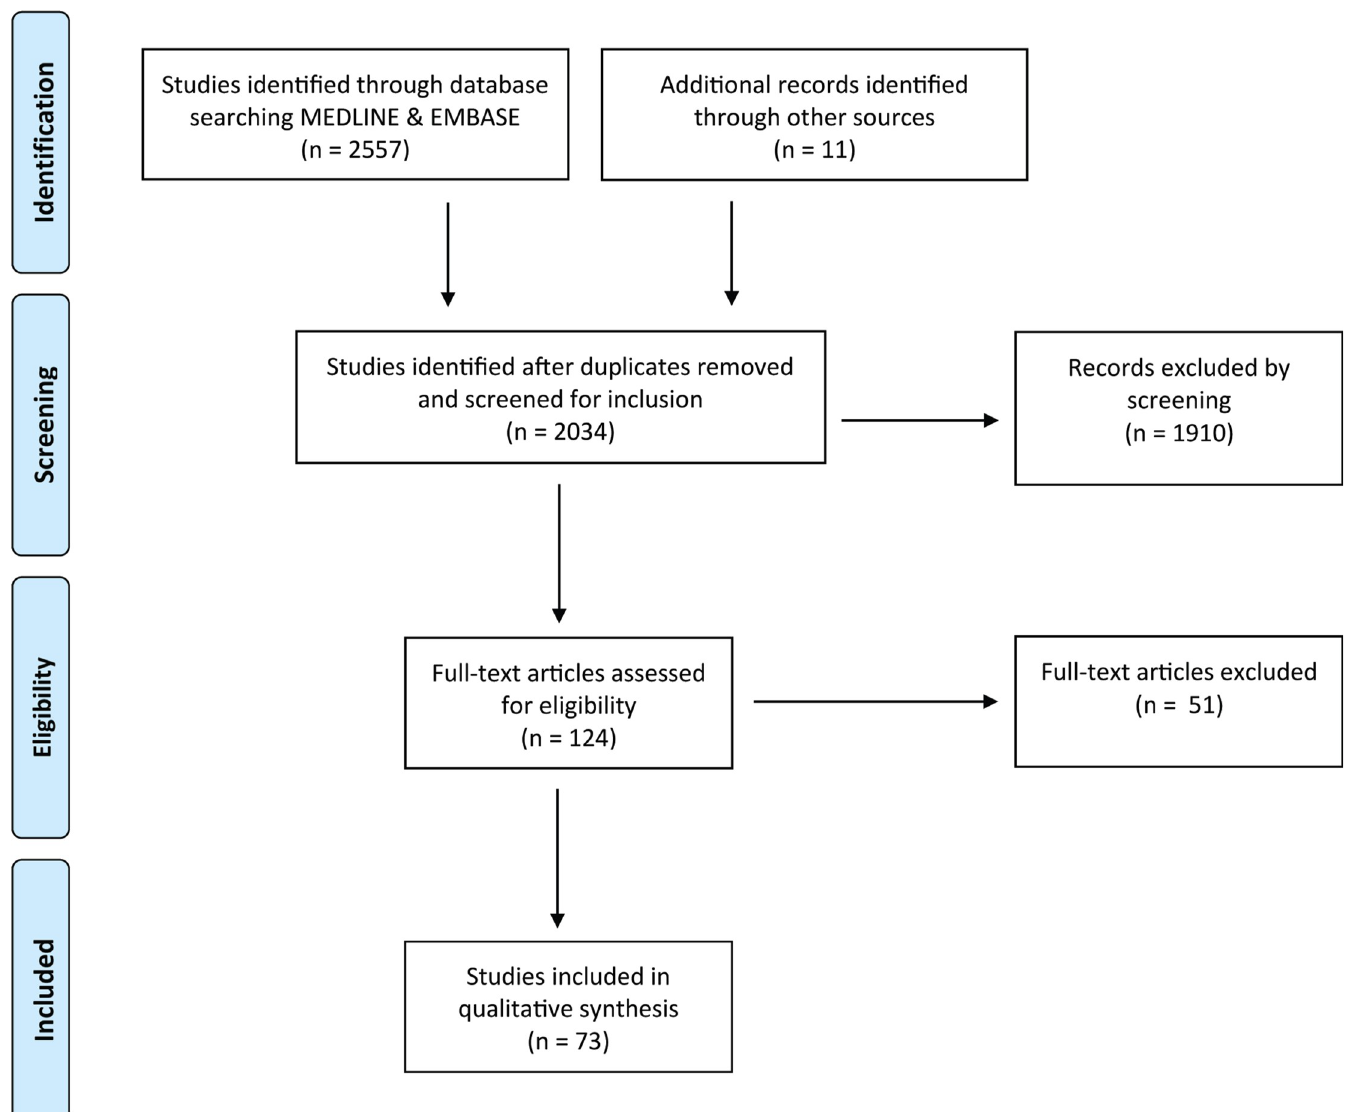
Fig 1. PRISMA flow-chart indicating the number of studies identified, screened, and confirmed for eligibility into this systematic review.